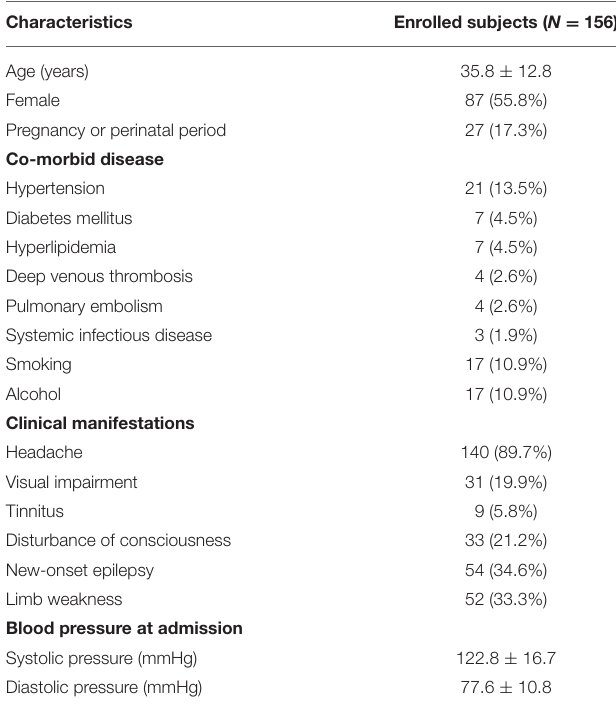
TABLE 1 | Baseline demographic features and clinical characteristics of patients with